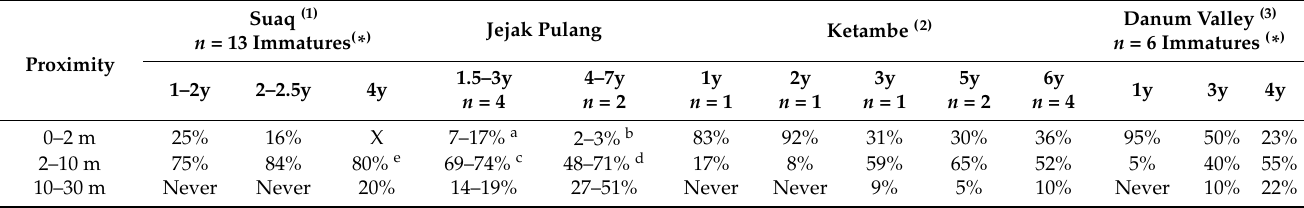
Table 7. Comparison of spatial proximity between mother-reared infants and our orphaned orangutans.